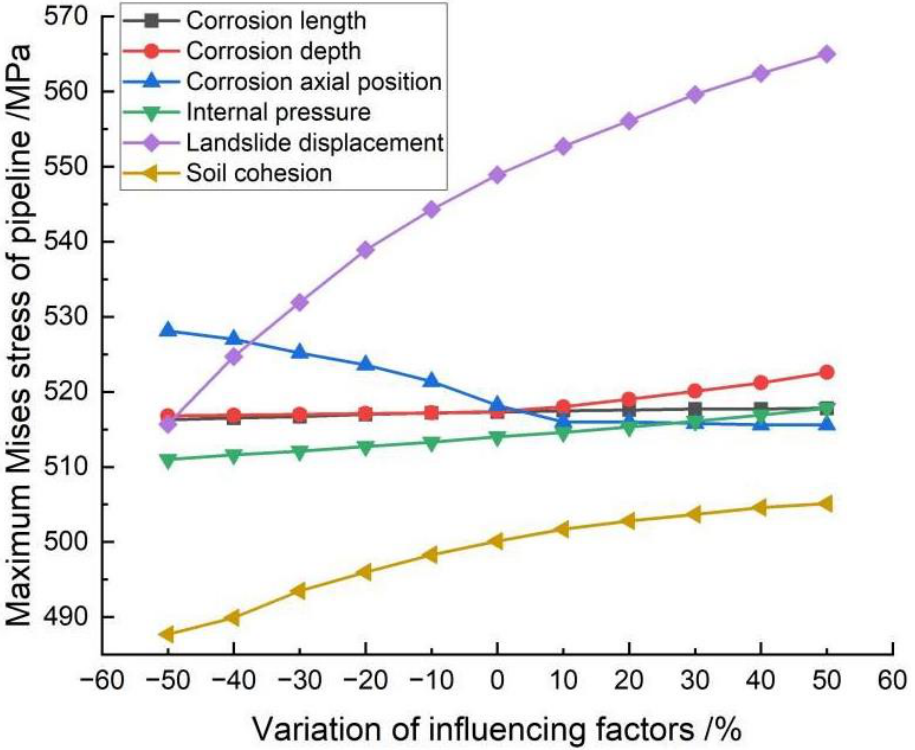
Figure 12. Sensitivity analysis of influencing factors.